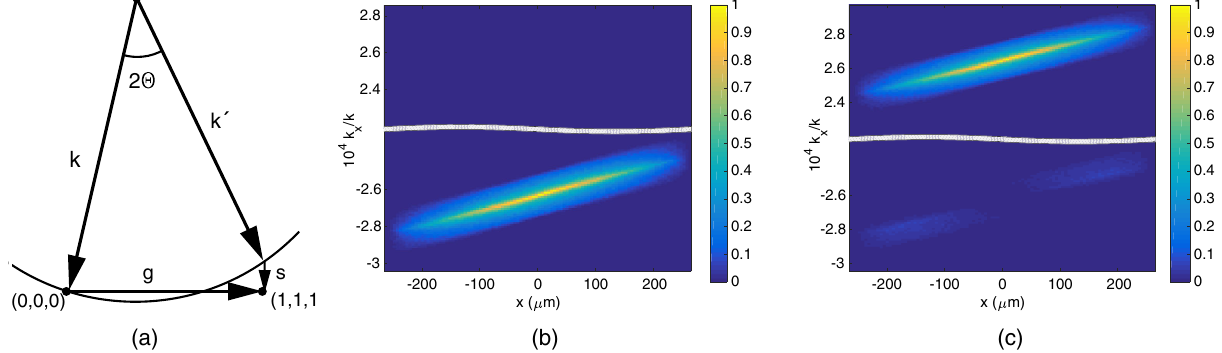
FIG. 2. (a) Scattering geometry for an incident particle. (b) The phase space of the incident electron bunch immediately prior to the target. (c) The calculated diffraction for the electron bunch from the rf photo-injector plotted as the relative density of electrons in the transverse phase space. With the thickness of the single crystal Si at t ¼ ξ = 2 , 98% of the beam undergoes one scattering event (upper panel). The remaining electrons (lower panel) did not